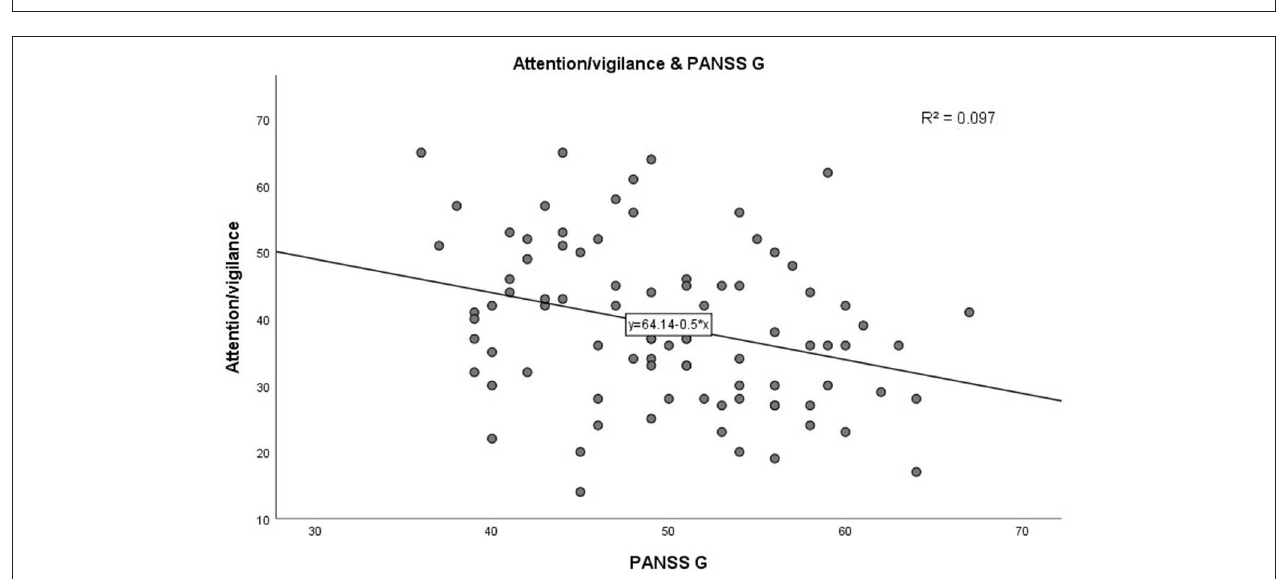
FIGURE 3 | Corrleation between PANSS G and